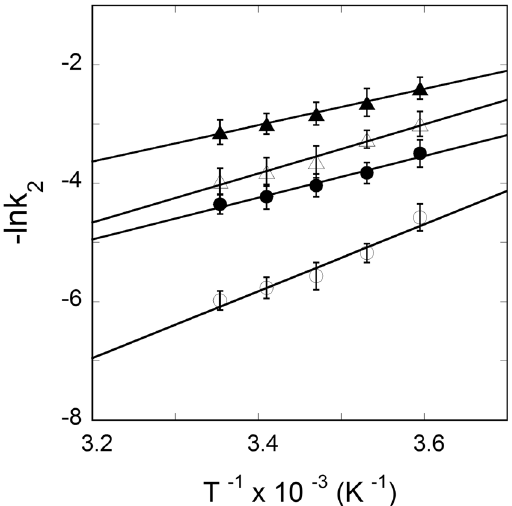
Figure 6. Determination of activation energies for the interaction of IRP1 with FRT and ACO2 IRE-RNA in the absence and presence of Mn 2 + . Rate constant values for FRT IRE-RNA ( ‒○‒ ), FRT IRE-RNA-Mn 2 + ( ‒⦁‒ ), ACO2 IRE-RNA ( ‒∆‒ ) and ACO2 IRE-RNA-Mn 2 + ( ‒ ▲ ‒ ) with IRP1 protein at different temperatures were used to construct an Arrhenius plot according to Eq. 5. Concentration of IRE-RNA, IRP1 and Mn 2 + were 50 nM, 1 µ M and 50 µ M, respectively. The activation energy was calculated from the slope of the fitted linear plot of ln k versus 1/T (kelvin). Data points in the plot of ln k versus 1/T were obtained from three independent experiments and the average value of the experimental data is